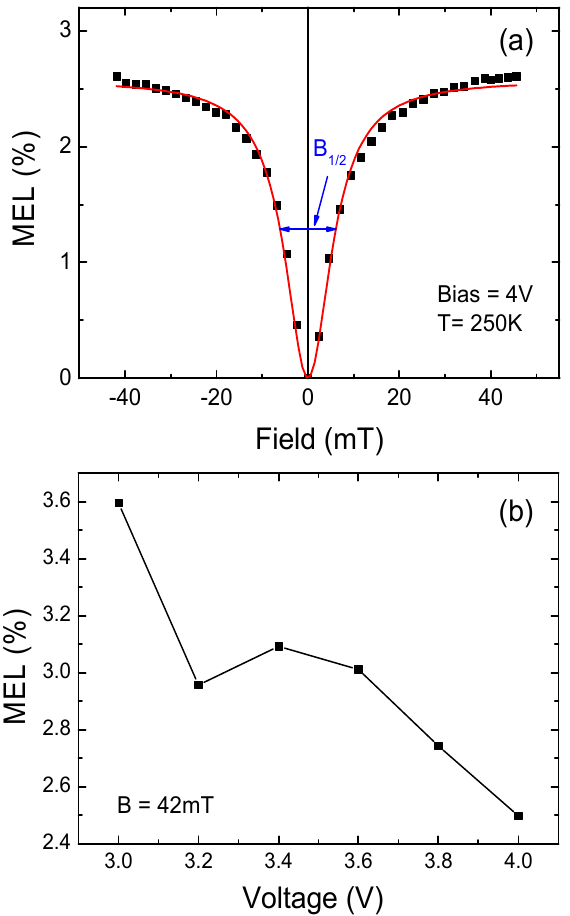
Figure 3. ( a ) The magnetic electroluminescence (MEL) response of the device under the bias voltage of 4 V at 250 K, the red solid lines show the Lorentzian line shape. ( b ) The MEL values as a function of bias voltage in the device under the applied field of 42 mT at 250 K.